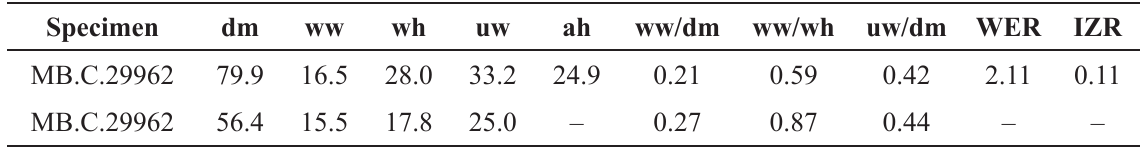
Table 21. Conch dimensions (partly estimated) and ratios of selected specimens of Clivotirolites petilus Korn & Hairapetian gen. et sp. nov. from Baghuk